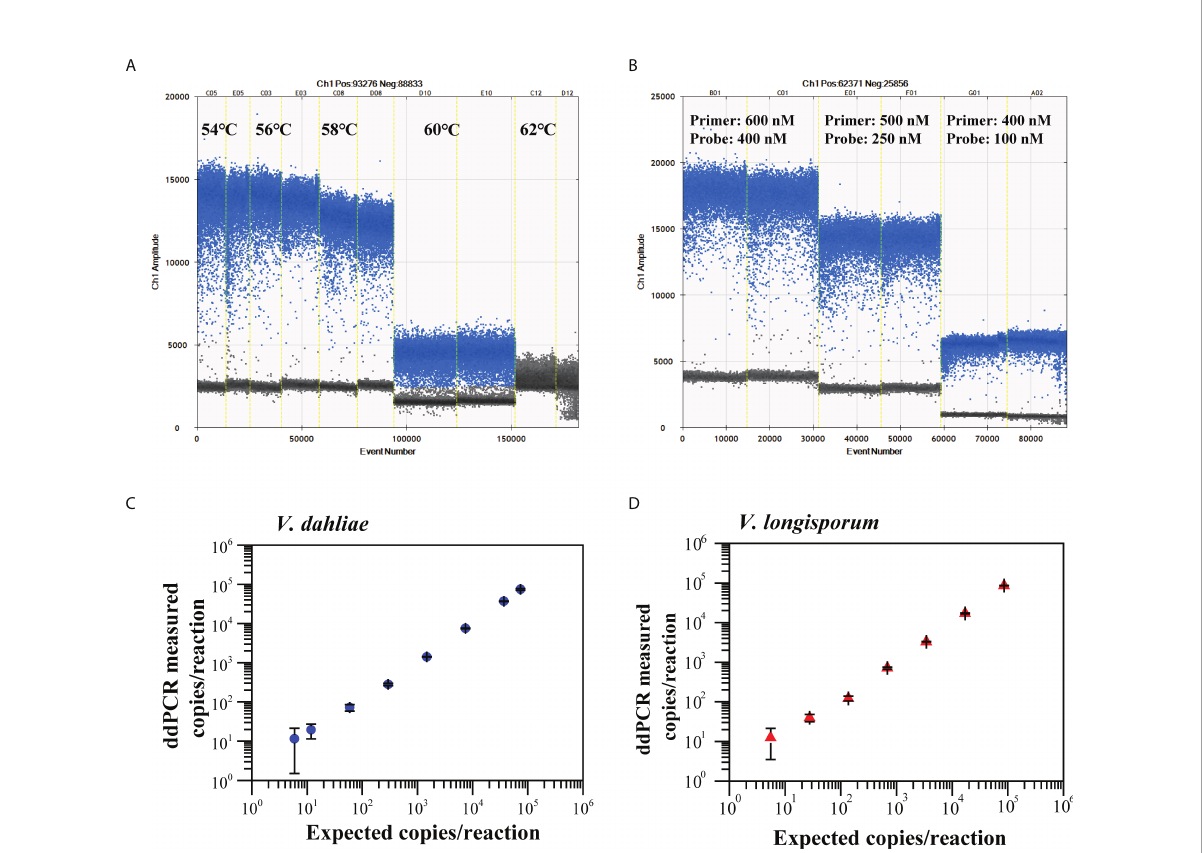
FIGURE 3 Optimization of annealing temperatures (A) and primer/probe concentrations (B) for ddPCR to quantify V. dahliae and V. longisporum . Linear regression of ddPCR assays for V. dahliae (C) and V. longisporum (D) . Means and standard deviation for each dilution series ( n = 3) are